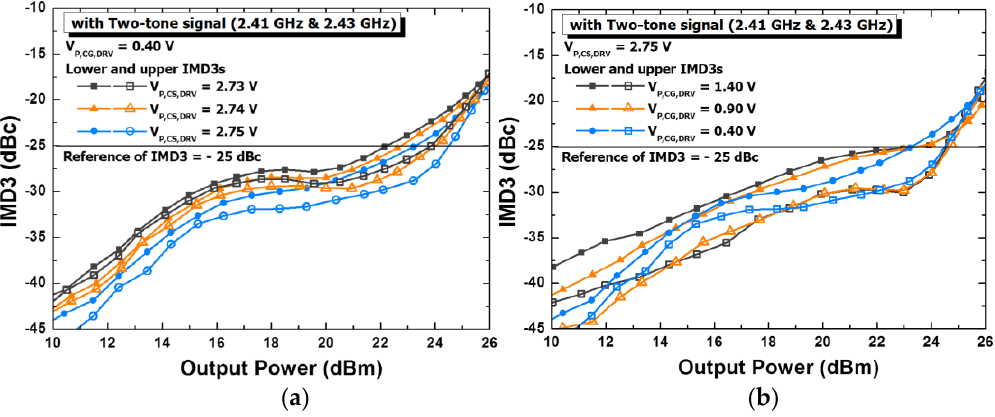
Figure 17. Measured results: IMD3s with two-tone signal for the various gate bias values: ( a ) V P,CS,DRV , ( b ) V P,CG,DRV .